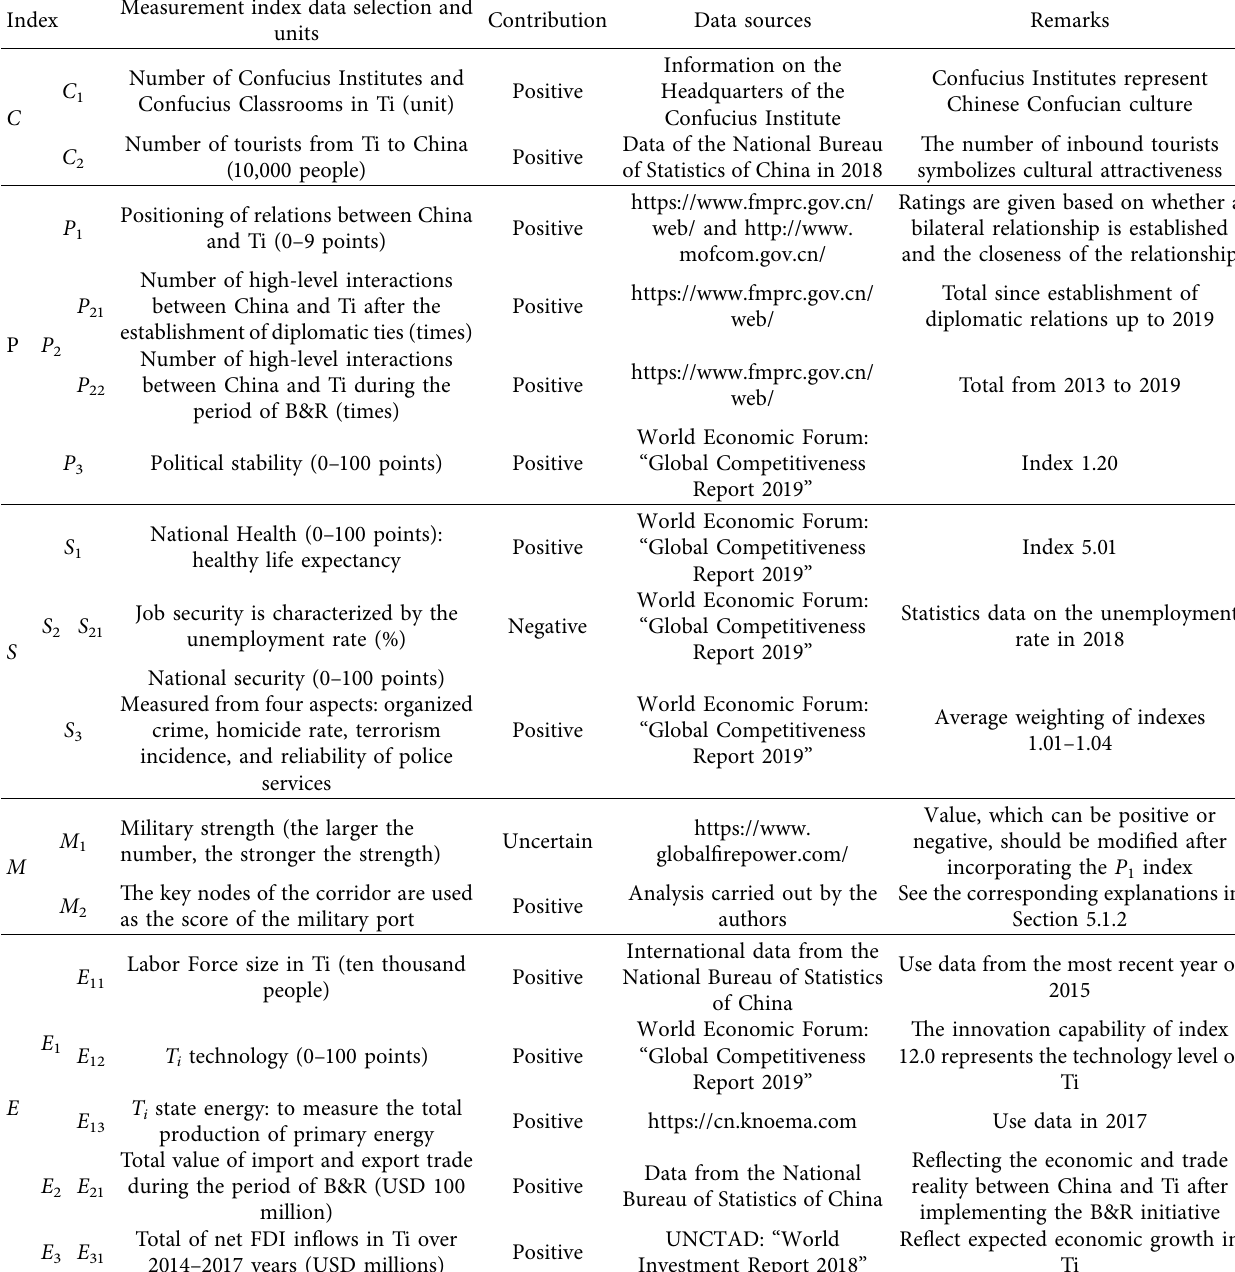
Table 2: Description of the indexes and data collection for assessing